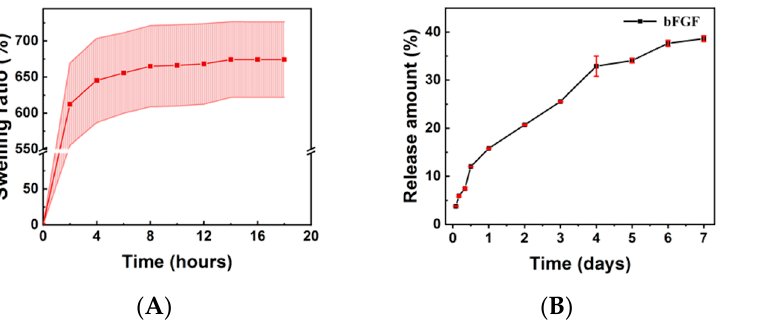
Figure 1. The profiles of bFGF-Gel in vitro. ( A ) The swelling behavior of bFGF-Gel. ( B ) bFGF release of the bFGF-Gel. ( C ) Storage modulus G ′ and loss modulus G ″ versus time during the bFGF-Gel degradation process.